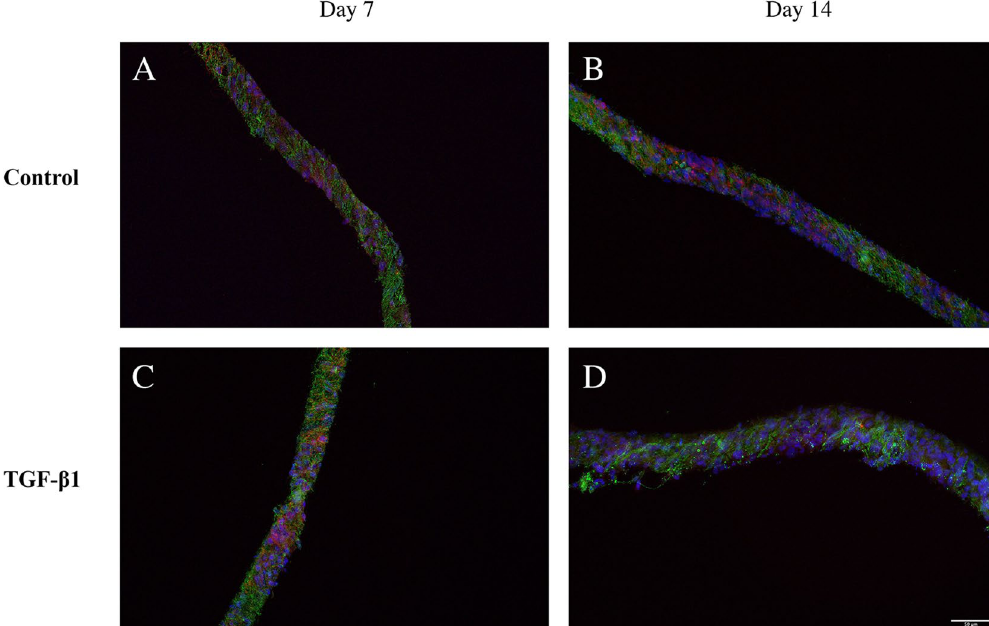
Figure 10. Fluorescence microscopy images of cryosectioned 3D JIMT-1/HDF co-cultures incubated in the absence or presence of TGF-β1. The JIMT-1/HDF 3D cultures were incubated in the absence (control) or presence of TGF-β1 (5 ng/ml). After 7 and 14 days of incubation, cultures were fixed in 3.7% formaldehyde, stained to visualize actin filaments (red), fibronectin (green), and cell nuclei (blue), followed by cryosectioning, and fluorescence microscopy. All images are representative of 3 independent experiments. Scale bar is 50